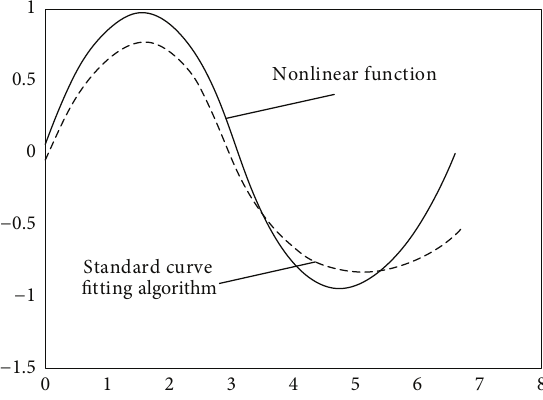
Figure 7: Traditional BP algorithm fitting